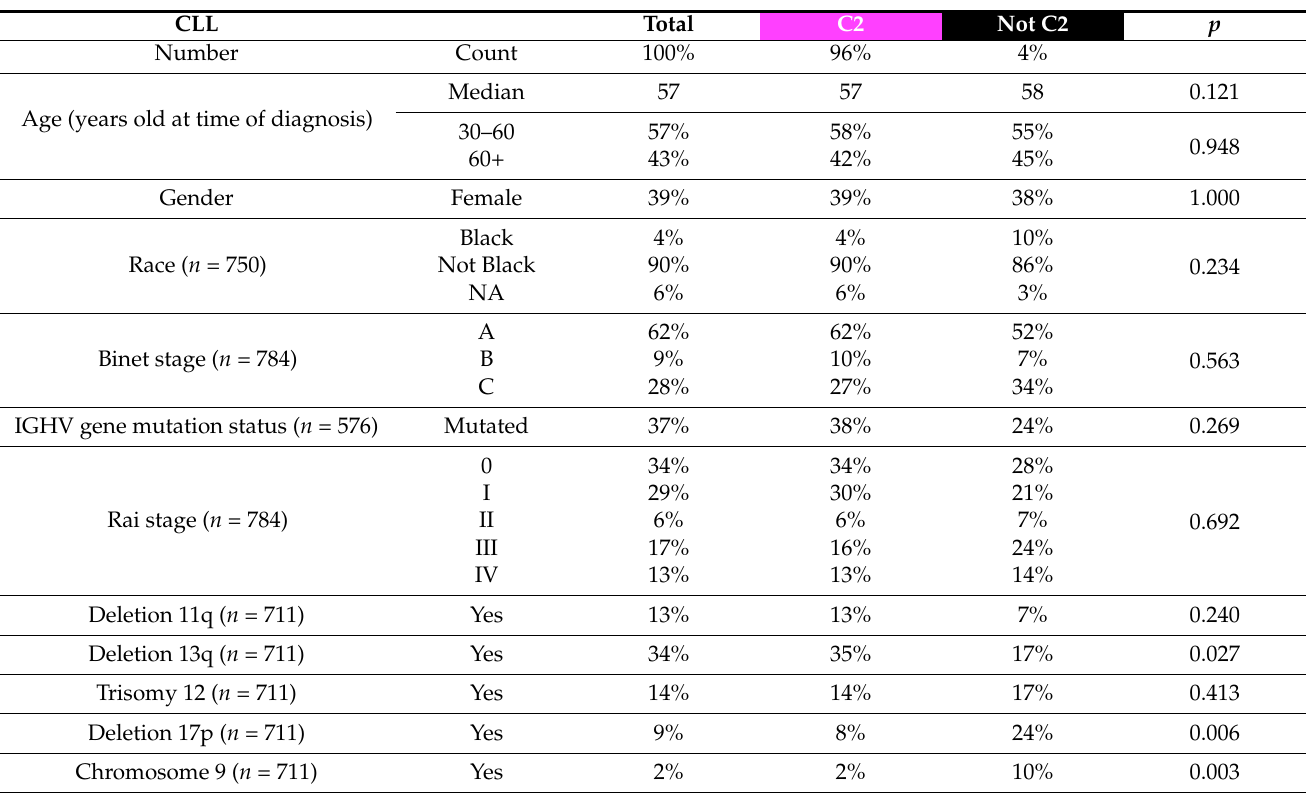
Table 4. Patient and disease characteristics across the five protein clusters in chronic lymphocytic leukemia